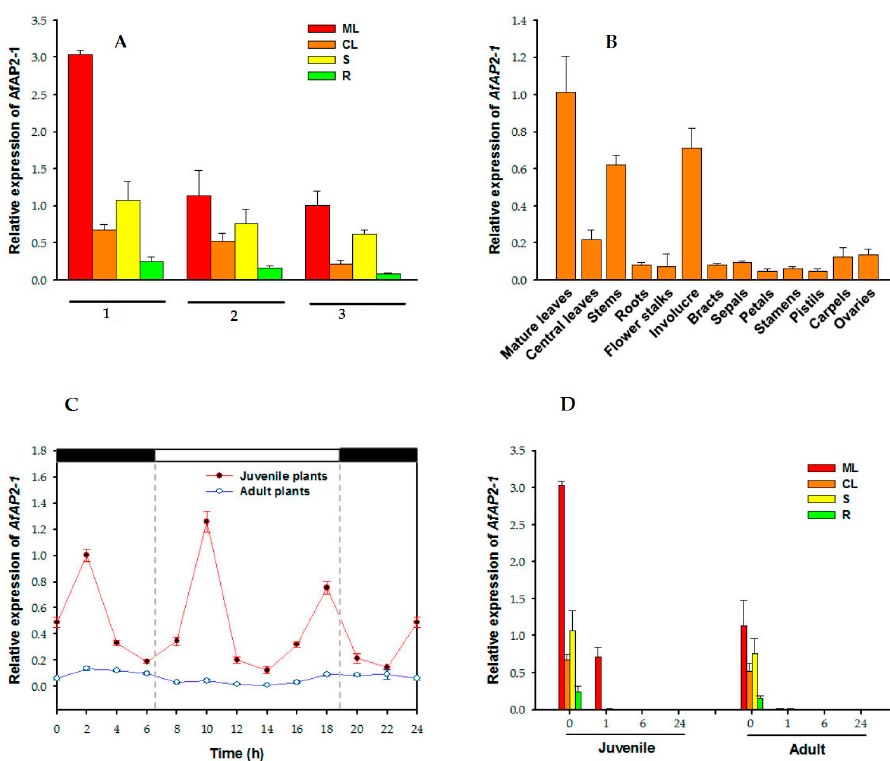
Figure 3. Expression of AfAP2-1 transcripts in various tissues of A. fasciata . ( A ) The expression level of AfAP2-1 transcripts in various tissues of juvenile and adult plants. 1, juvenile plants; 2, adult plants before differentiation; 3, adult plants of 39-DAF flowering. ML, mature leaves; CL, central leaves; S, stems; R, roots; ( B ) Expression level of AfAP2-1 transcripts in various tissues of 39-DAF flowering adult plants; ( C ) Expression level of AfAP2-1 transcripts in central leaves of A. fasciata grown in the greenhouse at natural daily light rhythm. Samples were collected at 2 h intervals. The dark bars indicate the dark period, and the white bar indicates the light period; ( D ) The expression level of AfAP2-1 transcripts in various tissues of A. fasciata in response to exogenous ethylene treatment for different times. 0, 1, 6 and 24 indicate the exogenous ethylene treatment time (h). Three independent experiments were performed, and values are shown as means and error bars indicate standard deviation ( n = 3).